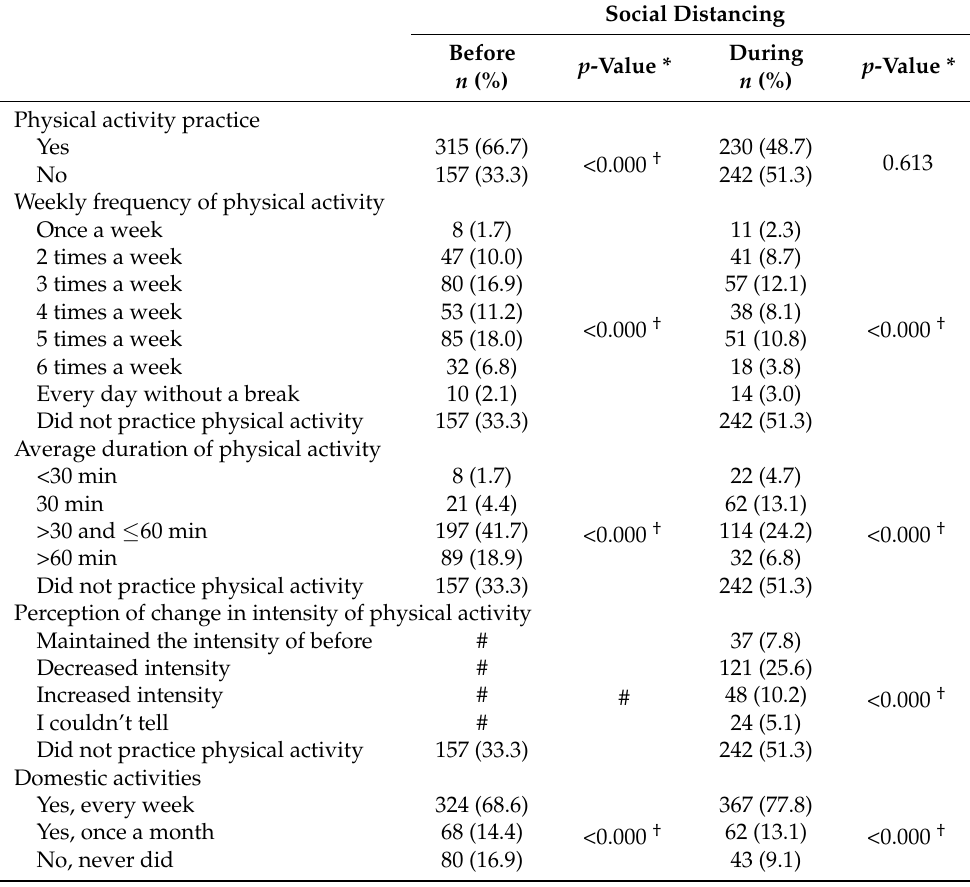
Table 2. Association between characteristics of social isolation and physical activity in individuals with type 1 diabetes during the COVID-19 pandemic in Brazil.